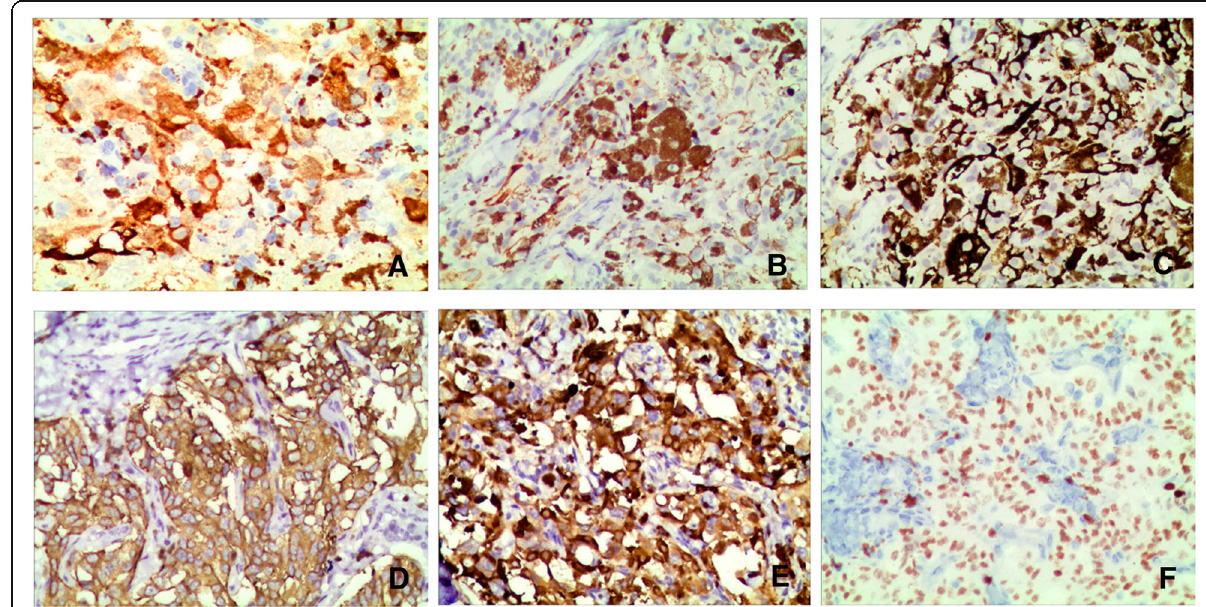
Fig. 2 10.1186/s13000-018-0764-2The immunophenotype of melanin-producing MTC. The tumor cells were positive for S-100 protein (2 a ), melan A (2 b ), HMB-45 (2 c ), syn (2 d ), calcitonin (2 e ) and TTF-1 (2 f ). (Magnification × 20)